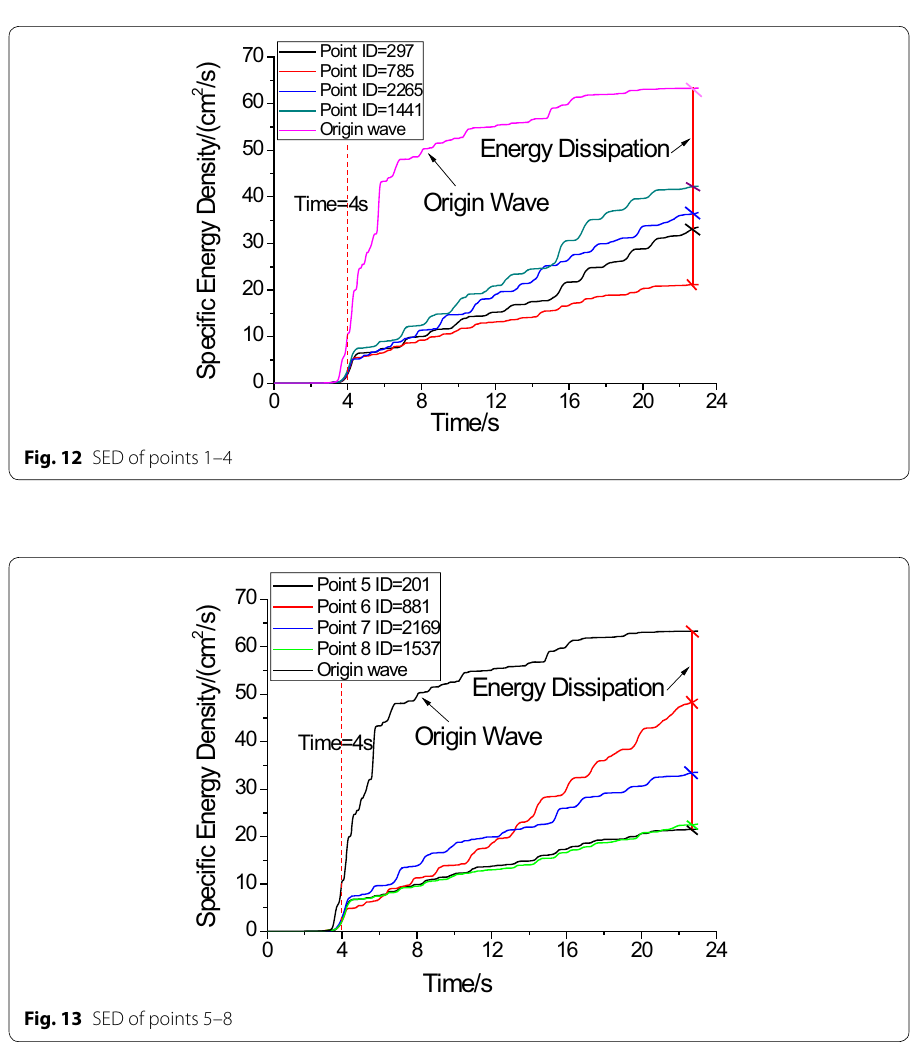
to the strong motion duration. The SED of origin wave is much higher than that of response wave of feature points around tunnel, because the energy dissipation happened continuously during the wave propagation though the elasto-plastic media. Obviously, both charts indicate that the points at upper cross-section of tunnel have larger wave energy dispersion than that of the points at lower part. That is to say, the plastic damage of upper section is also much more serious than the lower section, which means that more attentions are needed in the designing of supporting liner, especially joints and connecting interfaces, in the area with a high seismic level, comparing with the conven- tional method. However, due to the excavation and gravity of the overlying rock, upper section elements seem like have less damage, but this is not